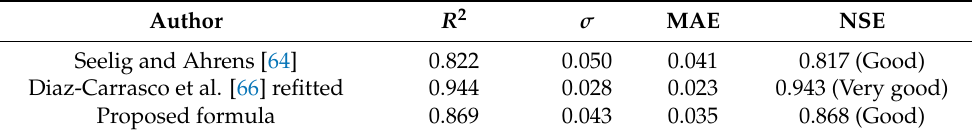
Table 7. Best fit values estimated for the existing formulas and the proposed